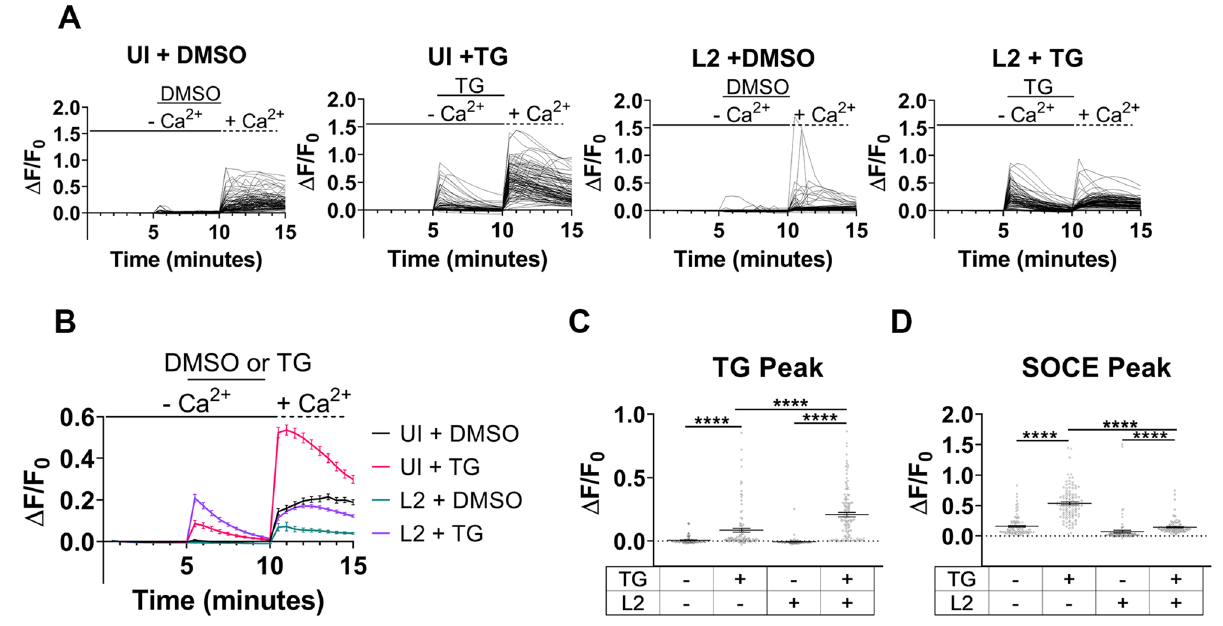
Single-cell analysis of the relative change in Fluo-4 fluorescence during Ca 2+ re-addition assay was performed